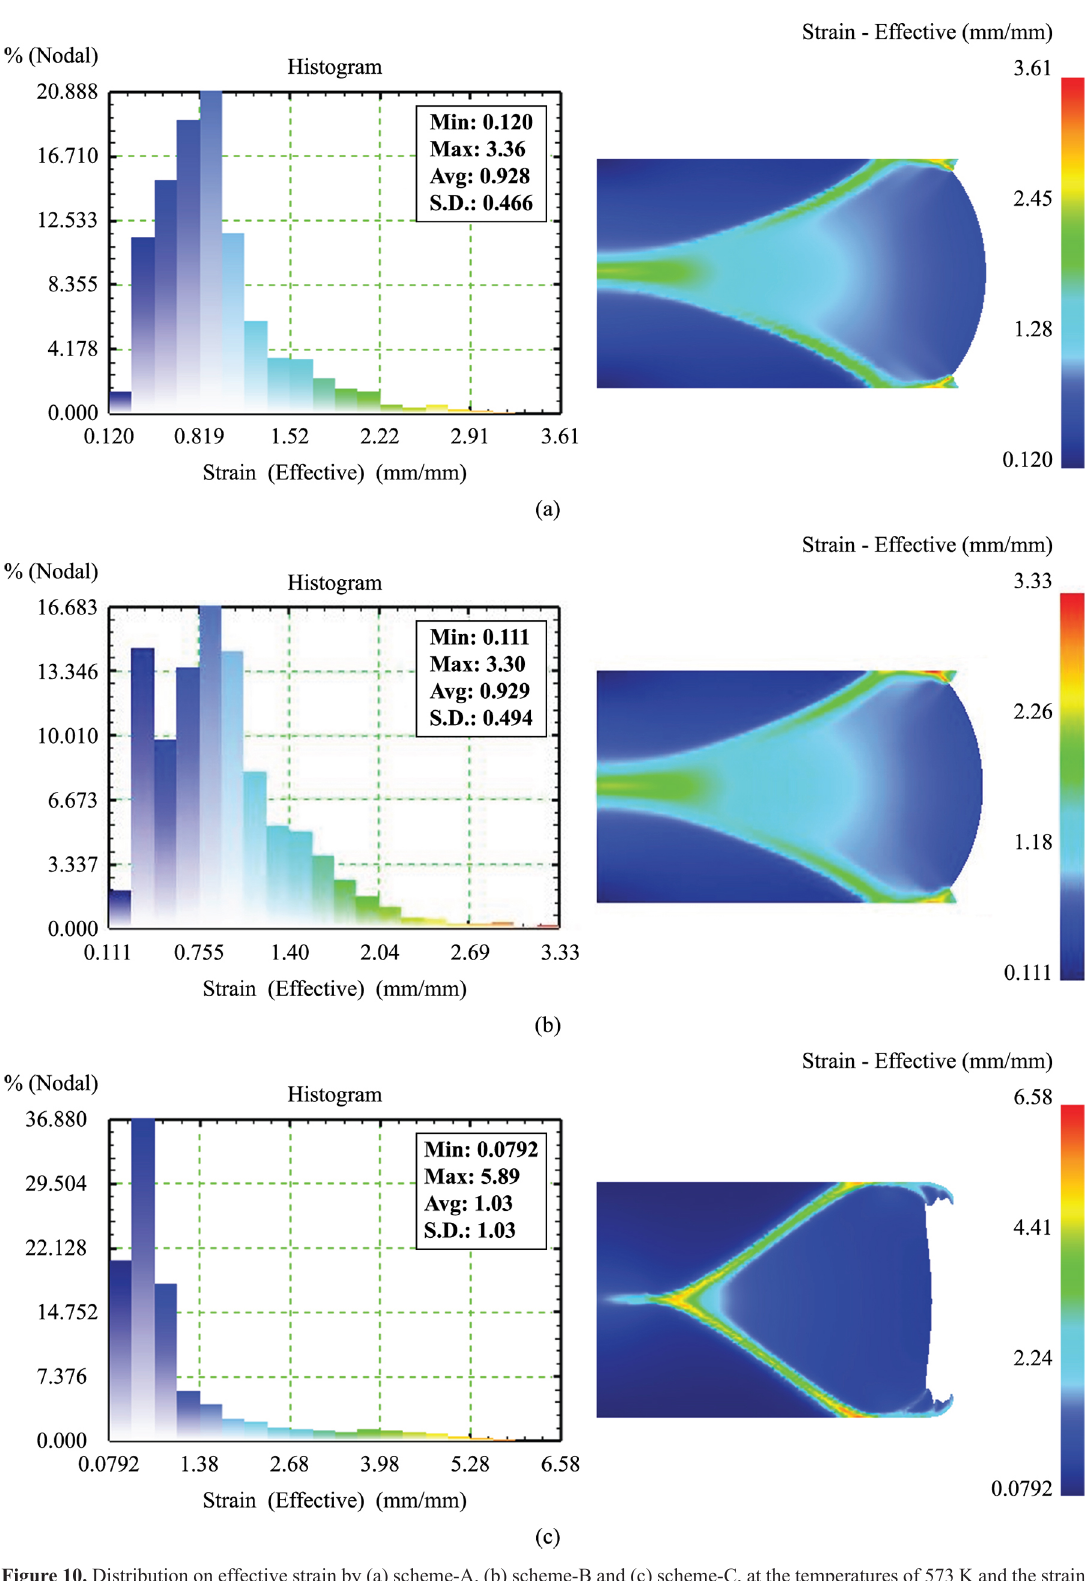
Figure 10. Distribution on effective strain by (a) scheme-A, (b) scheme-B and (c) scheme-C, at the temperatures of 573 K and the strain rate of 1s –1 , and the total height reduction of